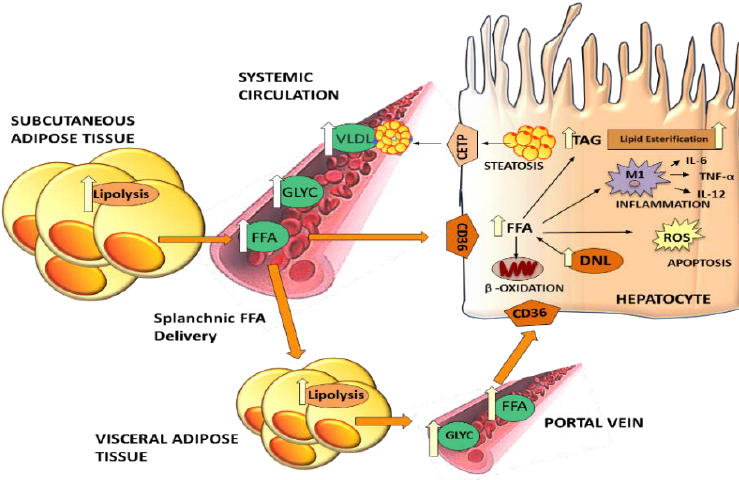
Figure 2. Effects of increased lipolysis on liver dysfunction. Excess lipolysis results in high free fatty acid (FFA) flux into the liver, where FFAs cause steatosis and exert lipotoxic effects. Triglycerides (TAG) synthetized in the liver are secreted into the plasma circulation as very low density lipoproteins (VLDL) causing dyslipidemia. Visceral fat has a preferential role in hepatic fat accumulation since released FFA reach the liver via the portal vein. Also increased hepatic de novo lipogenesis (DNL), inflammation and oxidative stress contribute to liver damage and hepatocyte dysfunction.